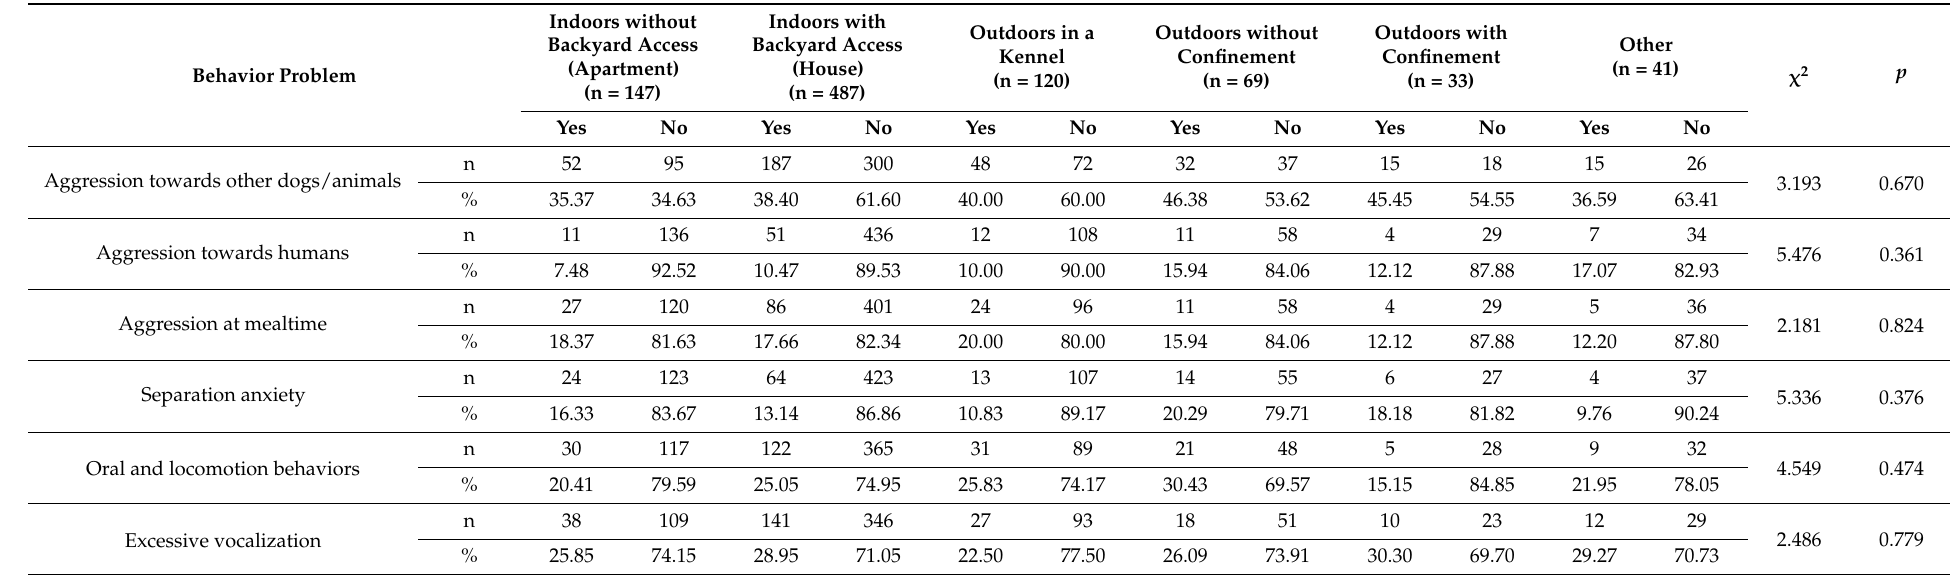
Table 5. The influence of previous housing conditions on the incidence of undesirable behaviors in ancient dog